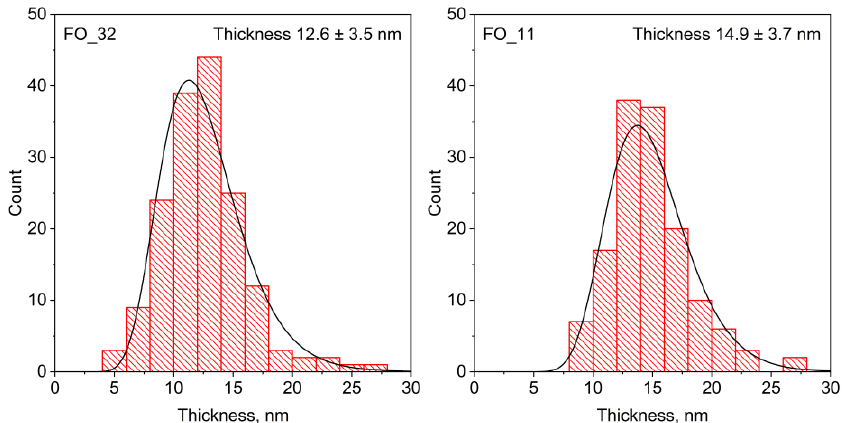
Figure A3. Selected area electron diffraction pattern (inset shows the selected area) and radial-integrated profile of SHF sample.